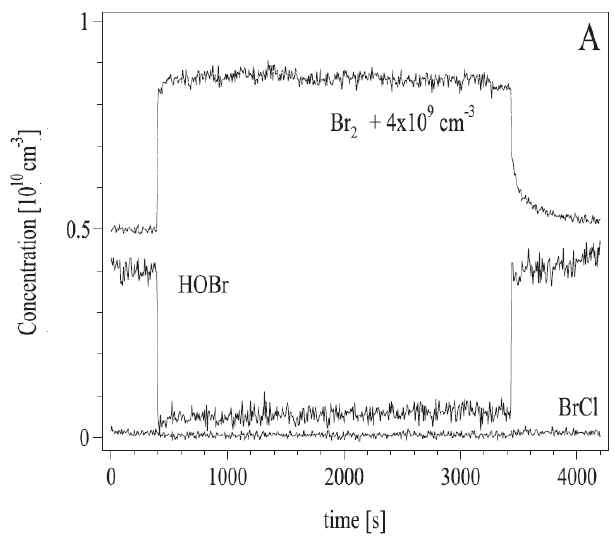
Fig. 6. Formation of Br 2 (and loss of HOBr) when gas phase HOBr is exposed to a frozen NaCl/NaBr solution at 233K at roughly 400s in a coated-wall flow tube. Note that no gas phase BrCl is formed. Taken from Adams et al. (2002) with permission of the